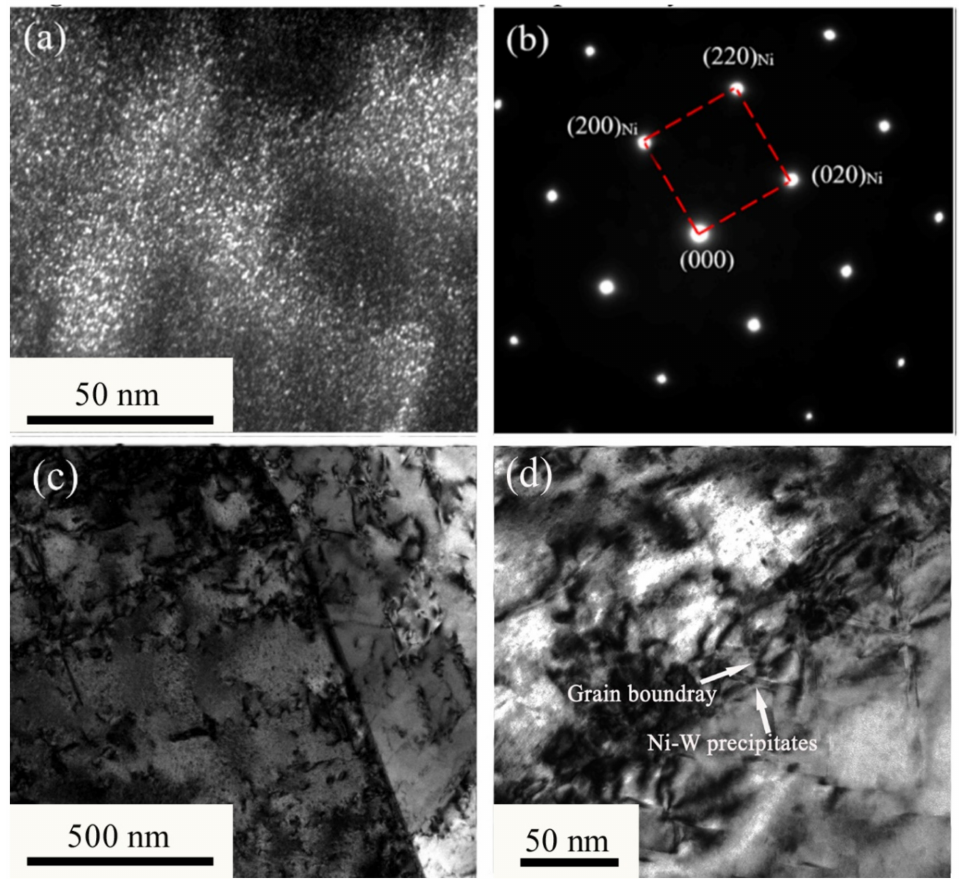
Figure 5. TEM micrographs of the samples obtained by stretching at 600 ◦ C: ( a ) dark-field image of the NiW phase, ( b ) [001]Ni SAED pattern of the sample, ( c ) TEM micrograph of the sample, ( d ) NiW phase near the grain